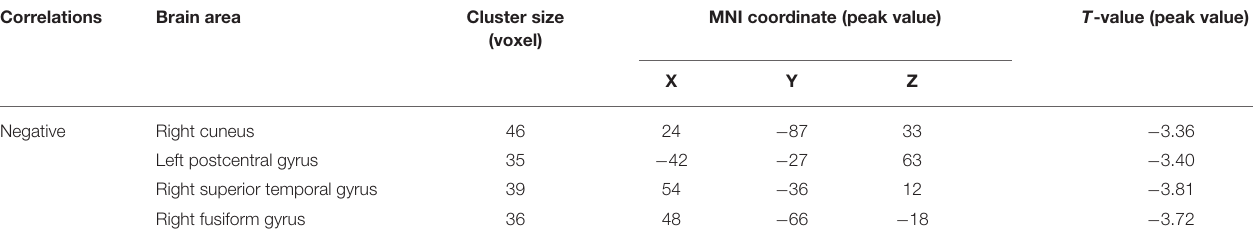
TABLE 5 | Correlations of ReHo values between brain areas and HAMD. Correlations